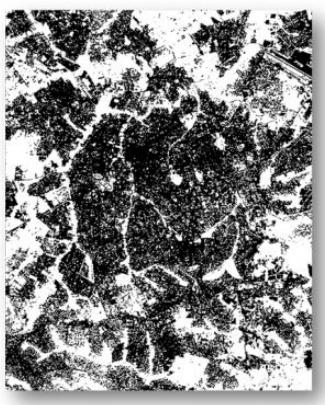
Figure 8 – Hue image for identifying the